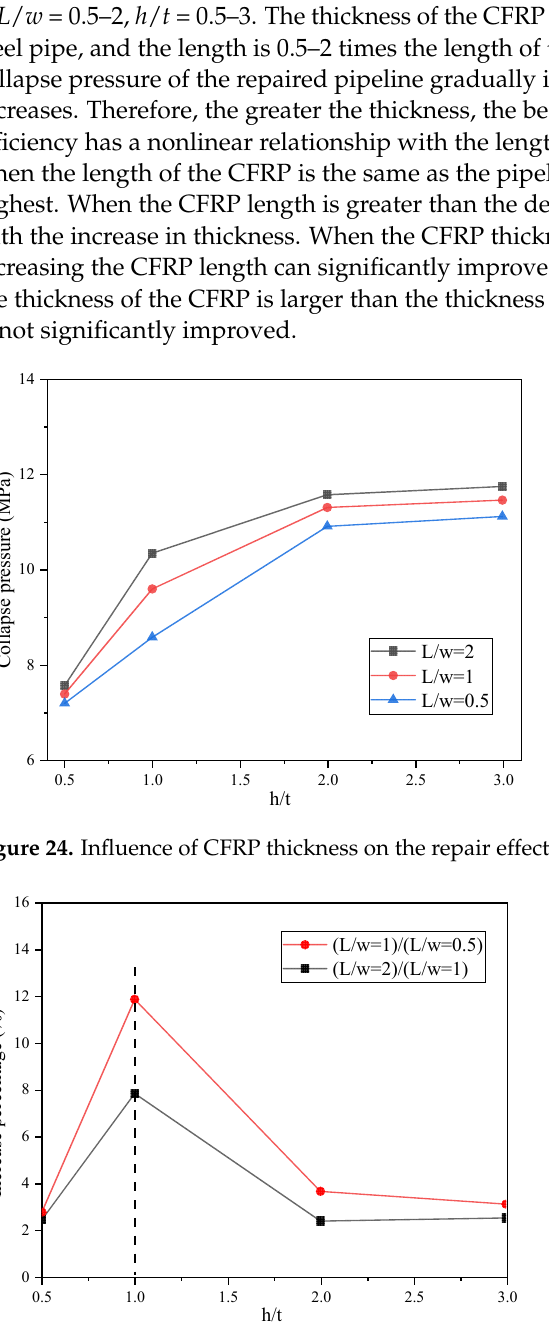
Figure 23. Comparison of the effect of metal loss rate.